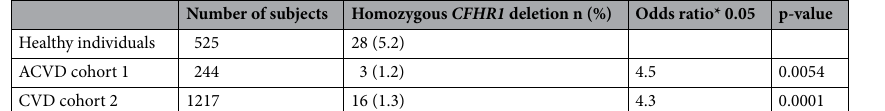
Table 1. Description of study cohorts. CAD coronary artery disease, ACVD atherosclerotic coronary vascular disease.